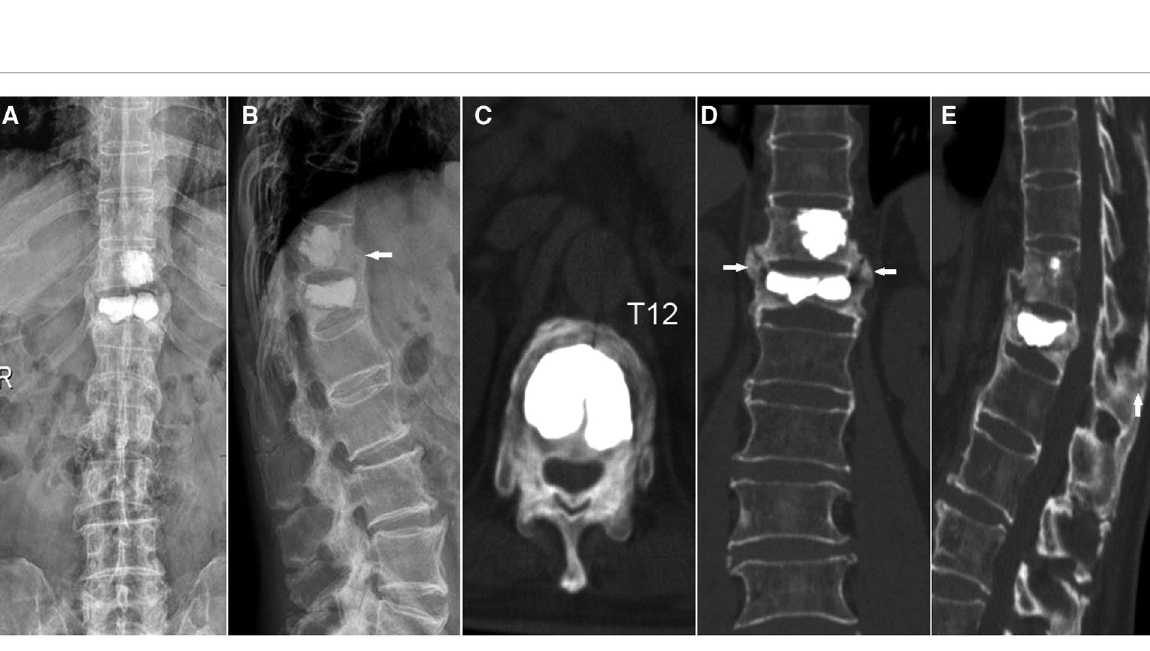
open surgeries with large trauma increase the risk of autoimmune process fatty degeneration of the paraspinal muscles and infection postoperatively. Only if SCI happens or the spinal